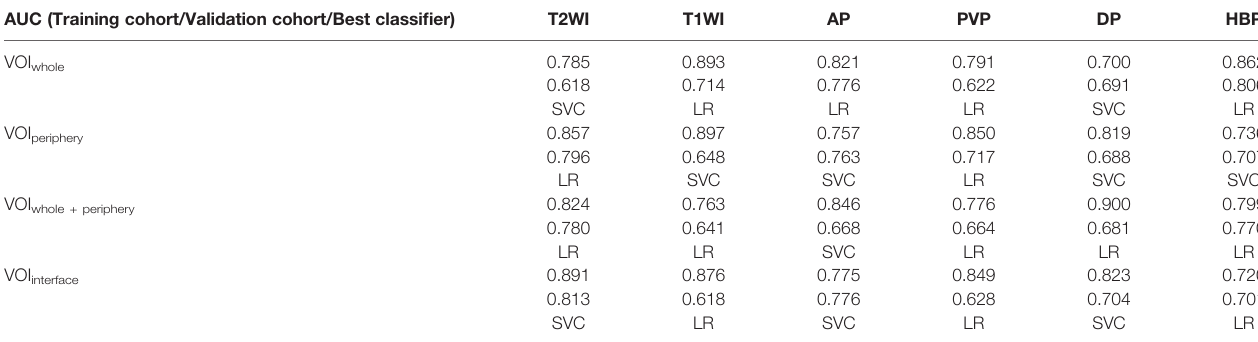
TABLE 3 | The performance of single-sequence radiomics models based on different VOIs. AUC (Training cohort/Validation cohort/Best classi fi er)